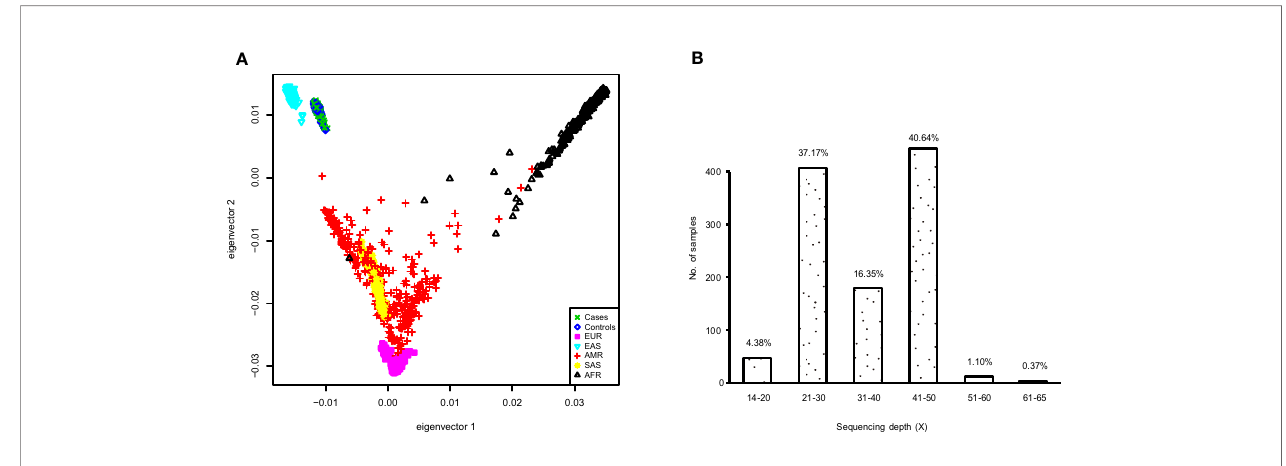
FIGURE 1 | (A) Principal component analysis (PCA) plot of subjects enrolled in this study based on two fi rst eigenvectors, built using all cases and controls in the genome-wide association study (GWAS) and, 2,504 individuals of European (CEU), African (YRU), American (AMR), South Asian (SAS), and East Asian (EAS) retrieved from the 1000 Genomes Project phase 3 release. (B) Distribution of the sequencing depth for the samples used in the